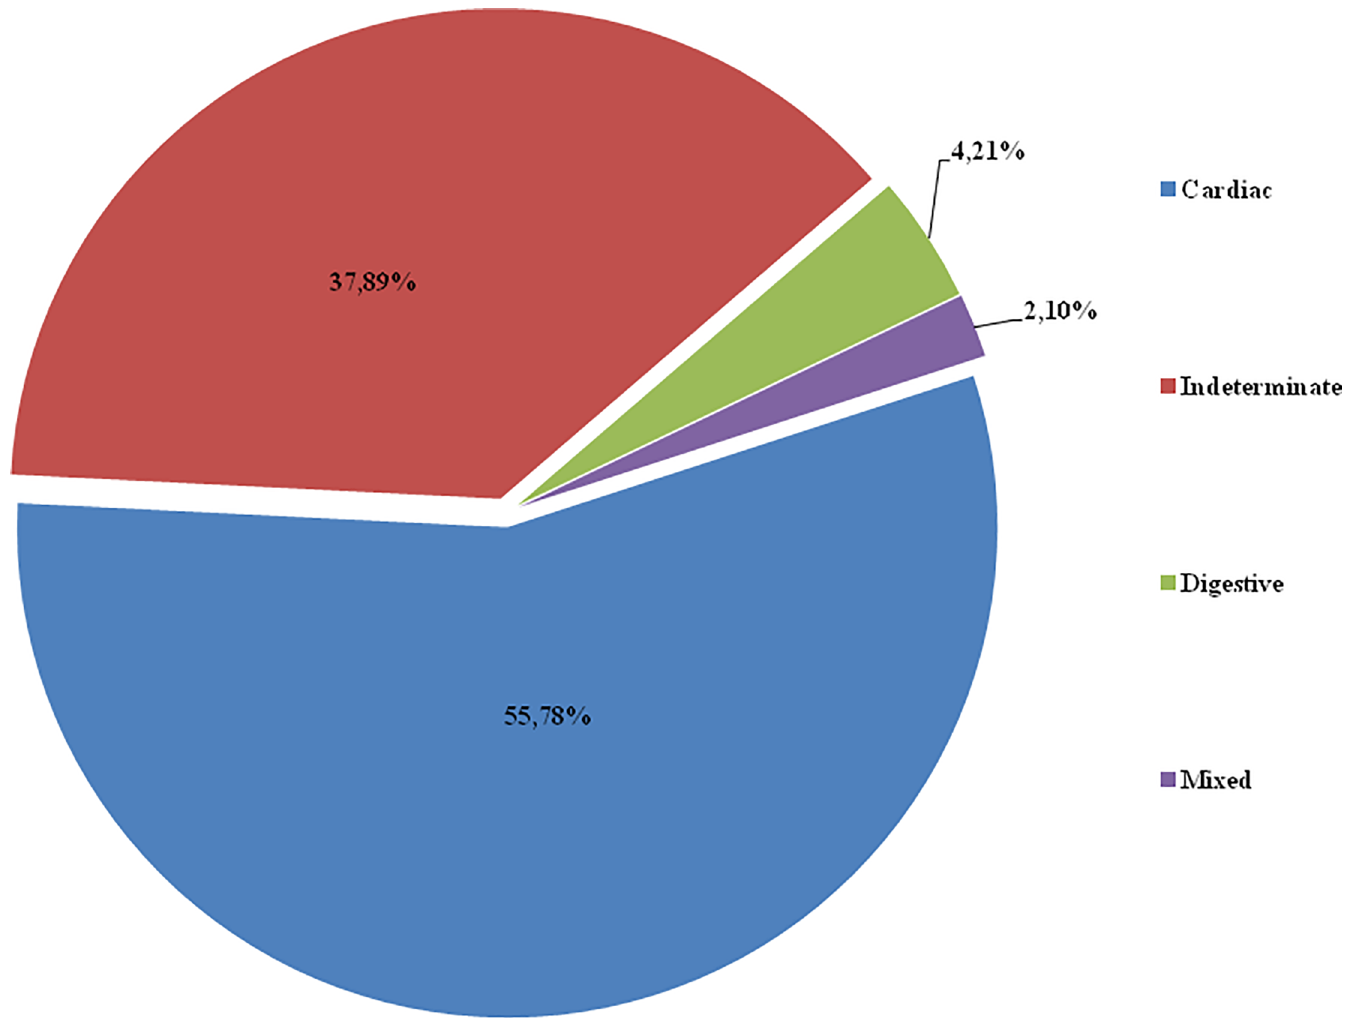
Fig 1. The clinical form. Frequency of clinical forms in patients with chronic dC, who underwent benznidazole treatment.